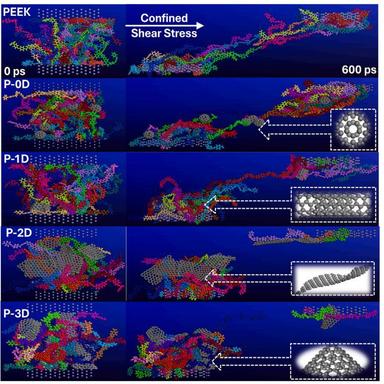
Structural conformations of PEEK/PNCs under confined shear stress during MD simulation representing initial and final states.